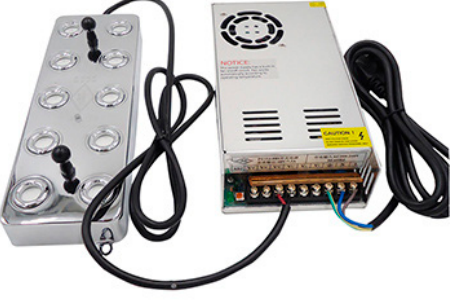
Figure 5. Ultrasonic water atomizer used in the